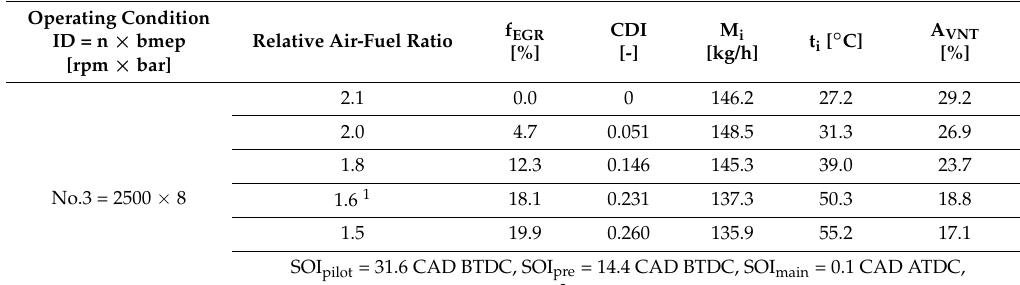
Table 4. Schedule of experimental activities for test Set 1 and average values of operating parameters (operating condition